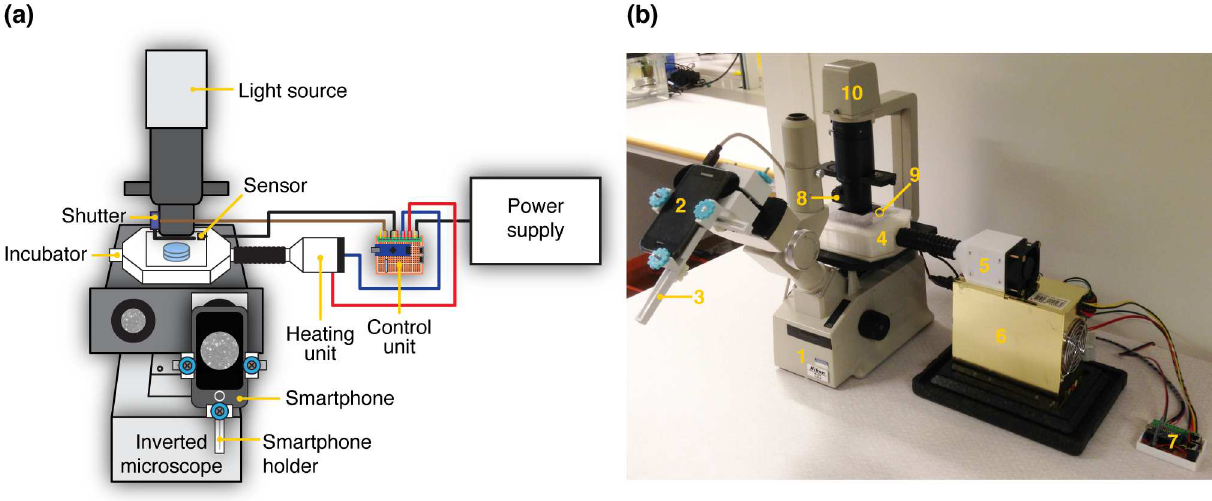
Fig 1. ATLIS: an affordable systemfor time-lapse imaging and incubation of cells. (a) The basic version of ATLIS was assembledby the combination of four modules.The imagingmodule ,composedof a smartphone, a 3D-printedholder, and a motorizedshutter, was designedto capture images of cells at a fixed intervalminimizingtheir exposure to light. The heatingunit was created to warm up the air introducedinto a 3D-printed onstageincubator where cells are kept. Finally, the control unit was programmed to maintaina constant temperature insidethe incubatorby adjustingthe power suppliedto the heatingunit. (b) A photographof the ATLIS mountedon a Nikon TMS microscopefitted with a SamsungGalaxy S I9000 smartphone. (1) Nikon TMS microscope; (2) SamsungGalaxy S I9000 smartphone; (3) smartphone holder; (4) onstage incubator; (5) heatingunit; (6) power supply; (7) control unit; (8) shutter; (9) temperature sensor; (10) light source.